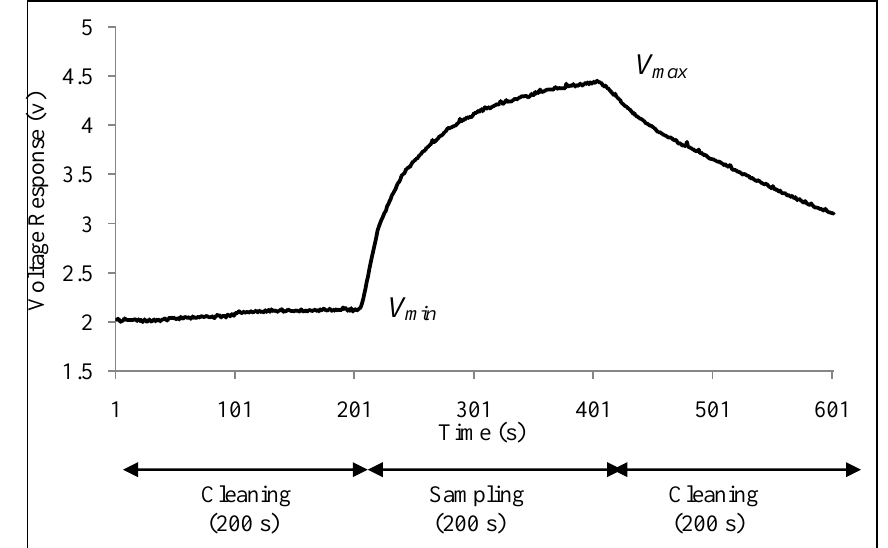
Figure 7. The typical orange juice voltage response captured by the TGS822.